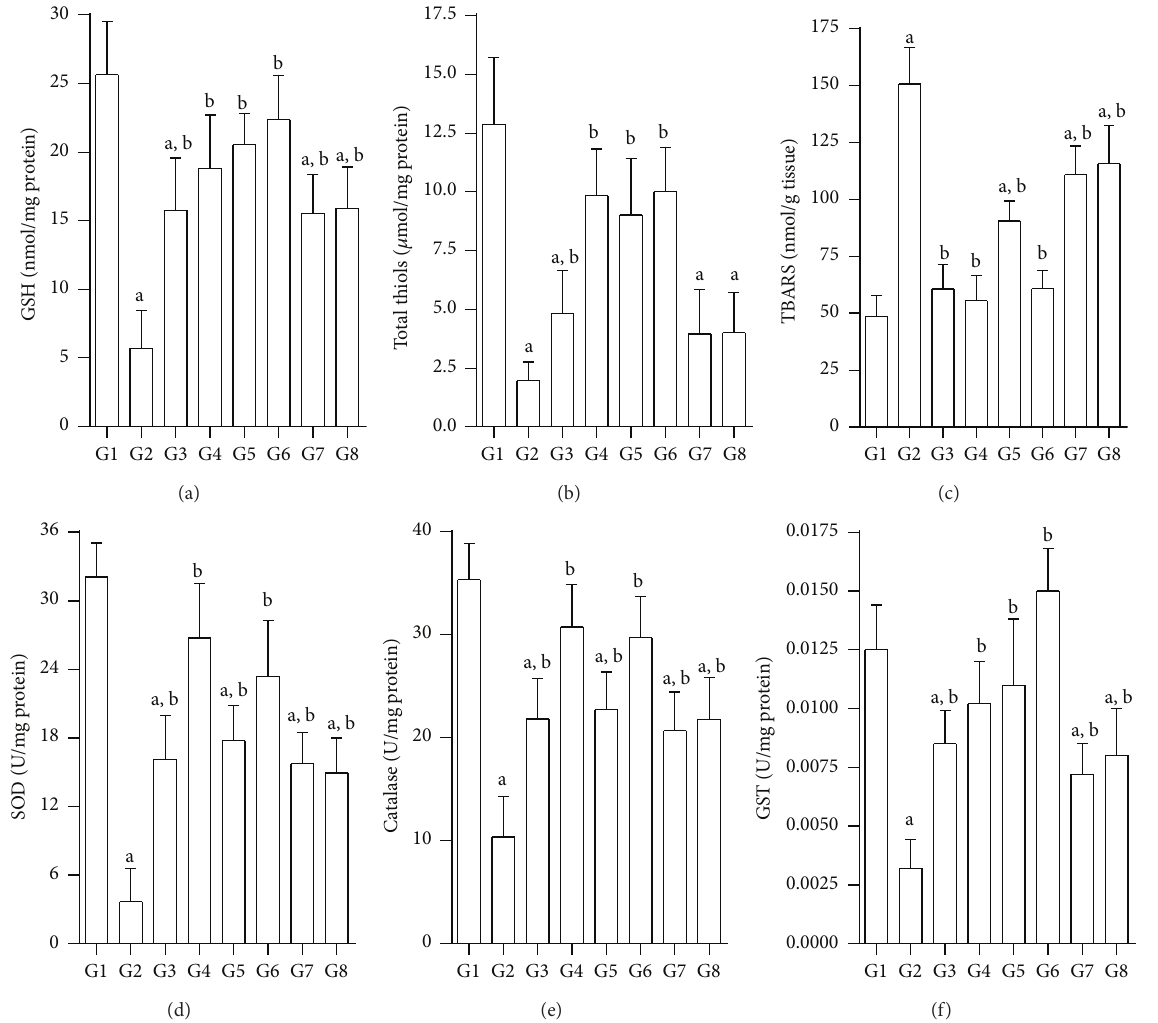
Figure 7: Effect of test compounds on enzymatic and nonenzymatic antioxidants and TBARS in nicotinamide, STZ diabetic rat liver; (a) glutathione (nmol/mg proteins); (b) total thiols ( 𝜇 mol/mg protein); (c) TBARS (nmol/g of tissue); (d) SOD (U/mg protein); and (e) catalase (U/mg proteins); (f) GST (U/mg proteins); G1: normal control; G2: diabetic control (nicotinamide + STZ); G3: diabetic + glibenclamide (2.5 mg/kg); G4: diabetic + quercetin (10mg/kg); G5: diabetic + JY-1; G6: diabetic + JY-2; G7: diabetic + JY-3; and G8: diabetic + JY-4; (test compounds at optimised dose of 80mg/kg); a 𝑃 < 0.05 compared to normal control (G1), b 𝑃 < 0.05 compared to diabetic control (G2) (one-way ANOVA followed by Tukey’s post-hoc